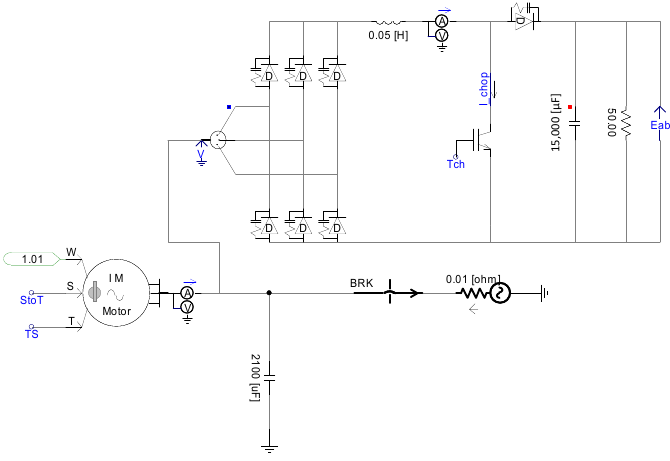
Figure 10. Modified electrolyzer system configuration.